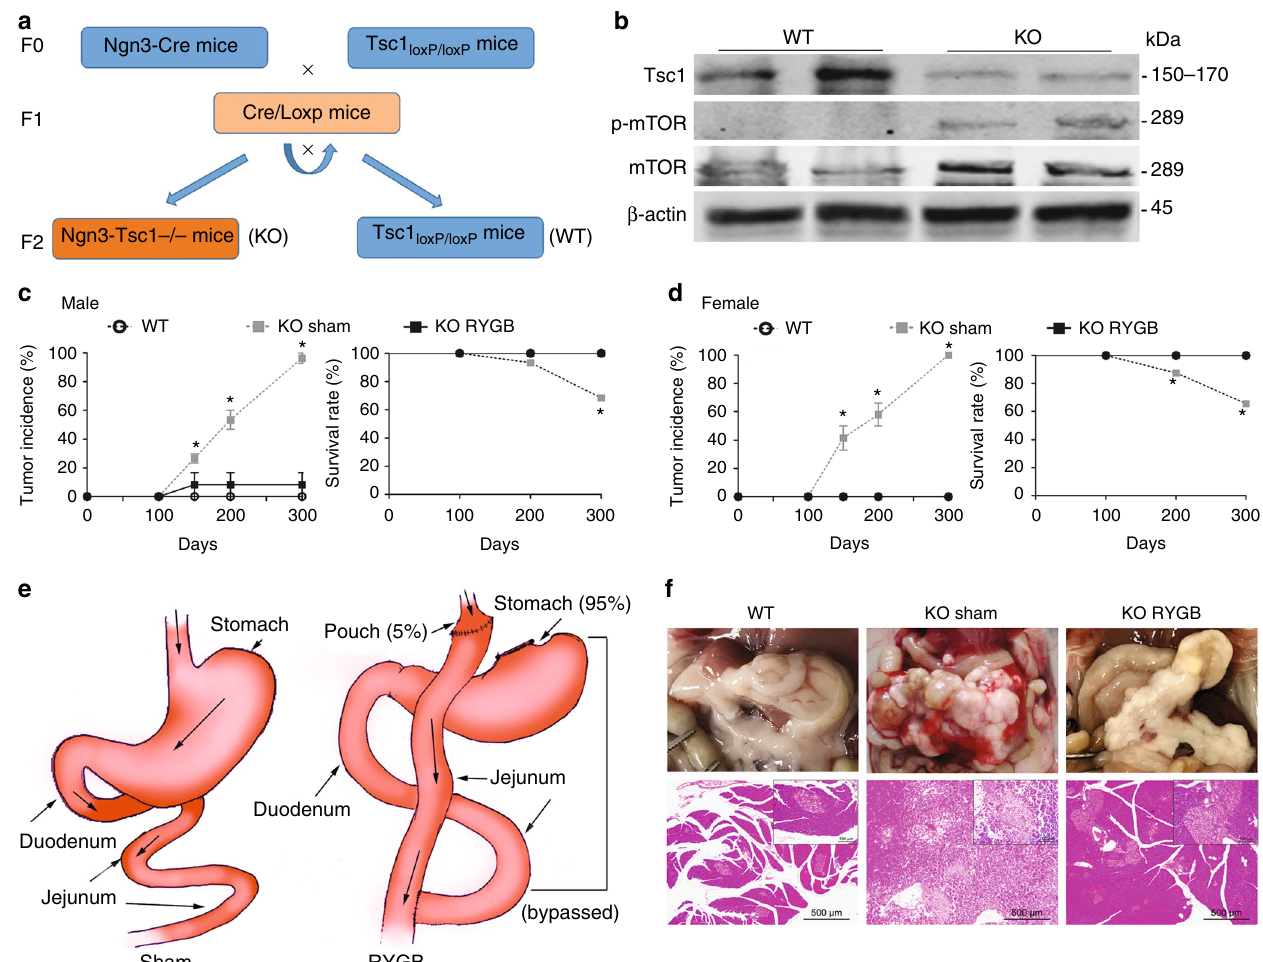
Fig. 1 RYGB surgery effectively prevents the occurrence of pancreatic ACC. a Schematic diagram illustrating the generation of Ngn3-Tsc1 − / − (KO) transgenic mice. b Tsc1, phospho-mTOR, and mTOR in pancreatic tissue of Ngn3-Tsc1 − / − (KO) transgenic mice were examined by western blotting using speci fi c antibodies. β -actin was used as loading control. n = 10, 6, 5 for WT sham, Ngn3-Tsc1 − / − (KO) sham, Ngn3-Tsc1 − / − (KO) RYGB, respectively. c Tumor incidence and survival rate of WT sham group, Ngn3-Tsc1 − / − (KO) sham group, and Ngn3-Tsc1 − / − (KO) RYGB group of male mice. Statistical differences were analyzed by log-rank (Mantel-Cox) test. n = 9, 5, 5 for WT sham, Ngn3-Tsc1 − / − (KO) sham, Ngn3-Tsc1 − / − (KO) RYGB respectively. * P < 0.05 vs. Ngn3-Tsc1 − / − (KO) RYGB. d Tumor incidence and survival rate of WT sham group, Ngn3-Tsc1 − / − (KO) sham group, and Ngn3-Tsc1 − / − (KO) RYGB group of female mice. Statistical differences were analyzed by log-rank (Mantel-Cox) test. n = 8, 5, 4 for WT sham, Ngn3-Tsc1 − / − (KO) sham, Ngn3- Tsc1 − / − (KO) RYGB, respectively. * P < 0.05 vs. Ngn3-Tsc1 − / − (KO) RYGB. e Schematic diagram illustrating sham (left) and RYGB (right) surgery. f